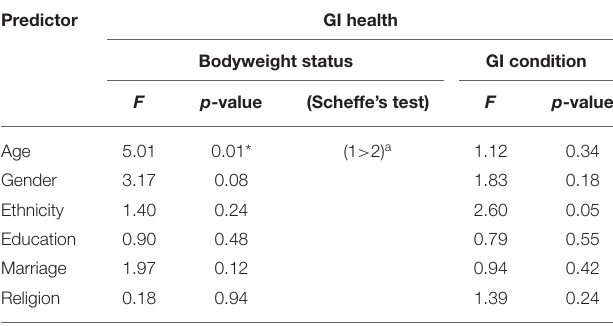
TABLE 4 | Predictors of GI health ( N = 300).